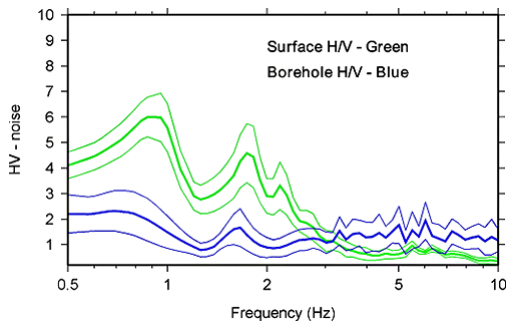
Figure 5. The horizontal to vertical spectra ratio of the ambient noise at the top (green lines) and bottom (blue lines). The amplifi- cation peak at 0.8Hz at the surface is smoothed at bottom, while the peak at 1.5–2Hz can be interpreted as stratigraphic boundaries.